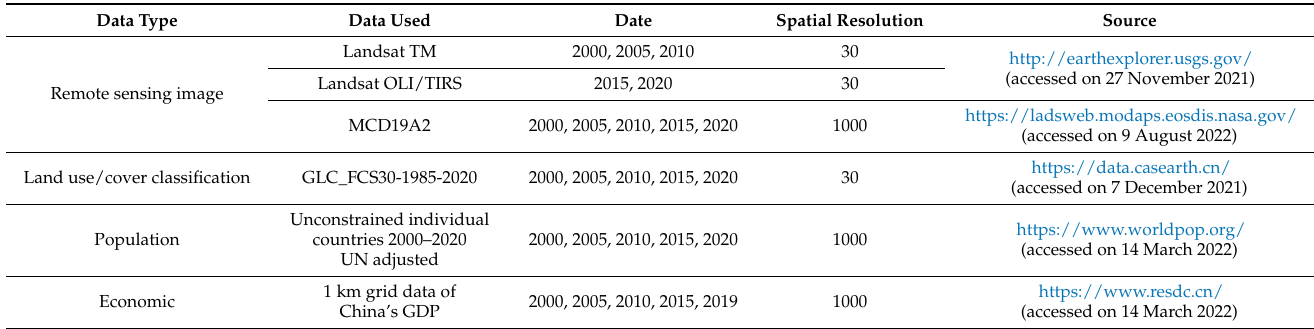
Table 1. Data used and their